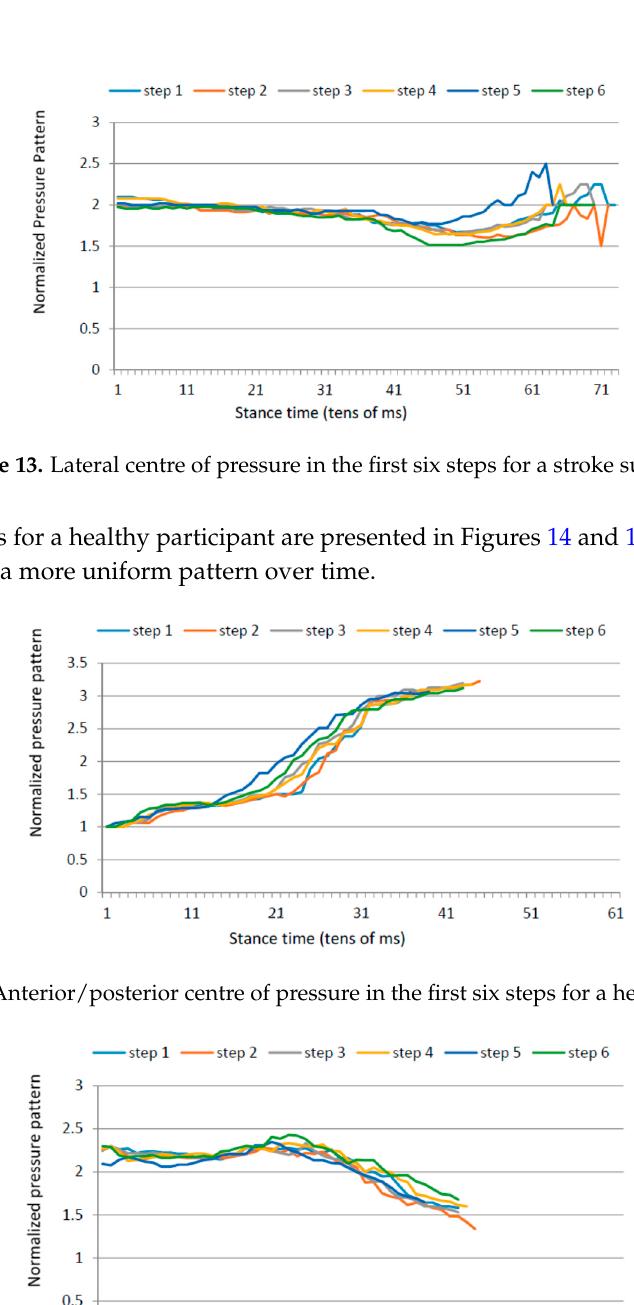
Figure 15. Lateral centre of pressure in the first six steps for a healthy control.